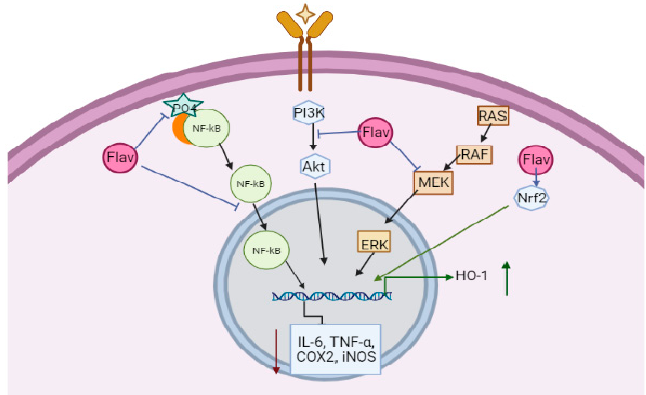
Figure 2. Major inflammatory pathways targeted by flavonoids.